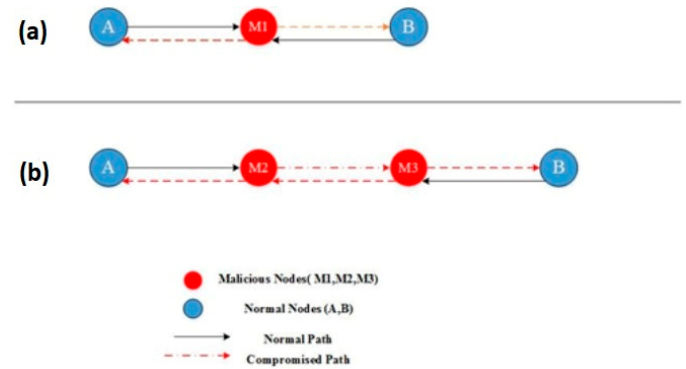
Figure 14. Deceptive routing information on WSN [84].